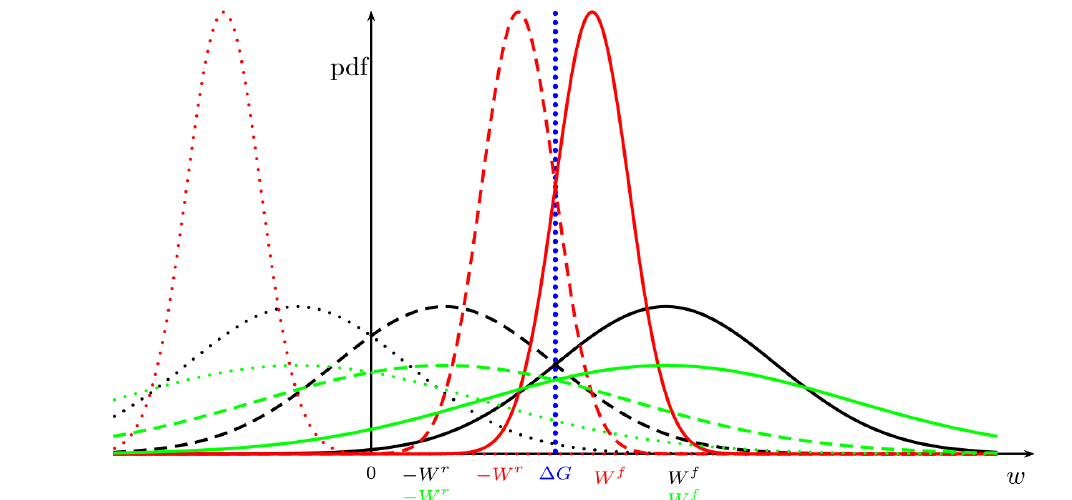
Figure 2. The pdf’s of the forward (pdf f ( w ), solid lines), the backward (pdf r ( w ), dotted lines) and the negative of the backward (pdf r ( − w ), dashed lines) processes are shown. The averages W f and − W r are given on the horizontal axis for the processes. The red line represents an experiment that was performed at a slower rate; less work is provided on average, and fluctuations are smaller as compared to the experiment corresponding to the black line. The green line represents an experiment that was performed at a lower dynamic β D as compared to the experiment corresponding to the black line; averages agree, but fluctuations are higher. The dotted lines are shifted by 2 (cid:49)G to the left with respect to the solid lines of the same color. The solid lines and the dashed lines of the same color all intersect at w = (cid:49)G and the dotted lines, and the dashed lines of the same color all intersect at w = 0. For an experiment performed at β D = ∞ (zero temperature) or an experiment performed at an infinitely slow rate T → ∞ , all the pdf’s are the delta function δ ( w − (cid:49)G ) (blue line) and the dynamics is